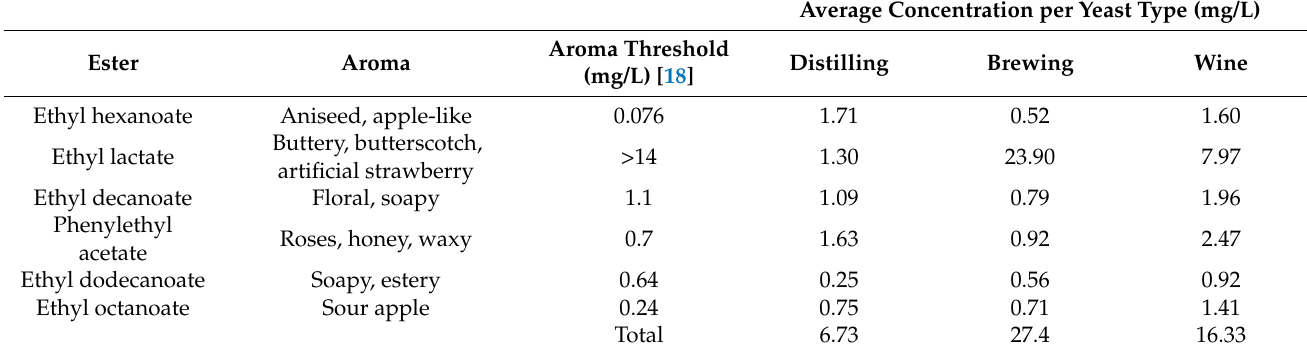
Table 3. Average ester concentration in new make spirit per yeast type: Distilling ( n = 8), Brewing ( n = 8), Wine ( n = 2). Average Concentration per Yeast Type